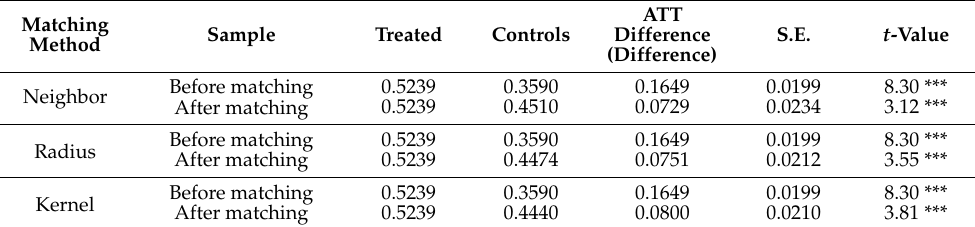
Table 9. Estimation results of average treatment effect of health status of rural elderly on their loneliness.